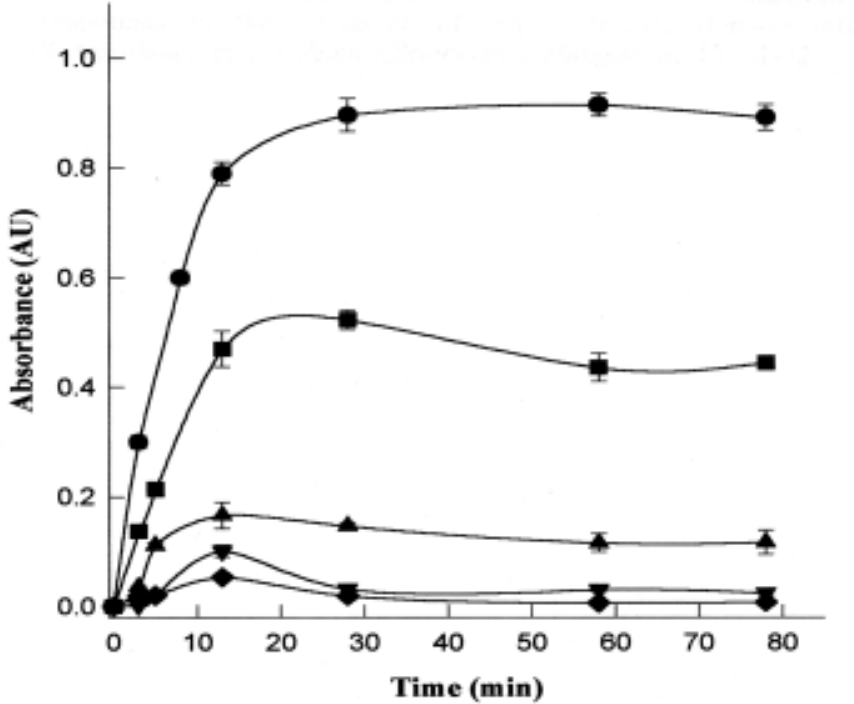
Fig. 4. Effect of different concentrations of p -coumaric acid on manganese peroxidase activity: ( ● ) Control, ( ■ ) 30 µ M, ( ▲ ) 150 µ M, ( ▼ ) 300 µ M, ( ◆ ) 600 µ